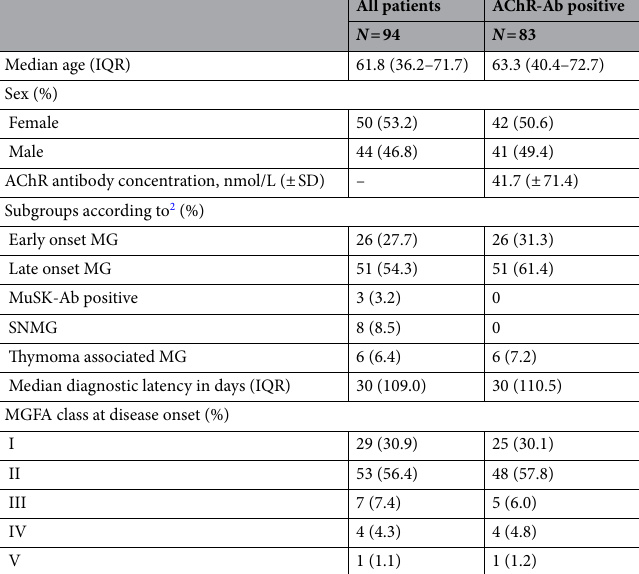
Table 1. Description of the entire study cohort and the AChR-Ab positive patients.